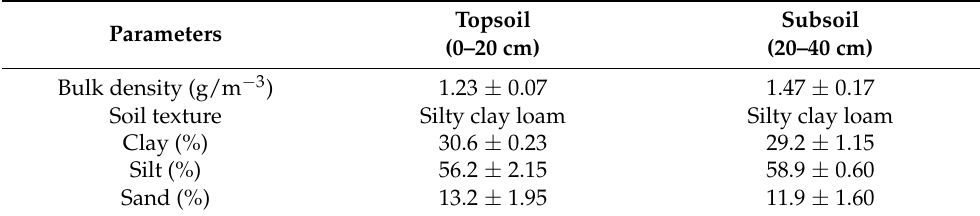
Table 3. The soil properties of the breeding field in this study.